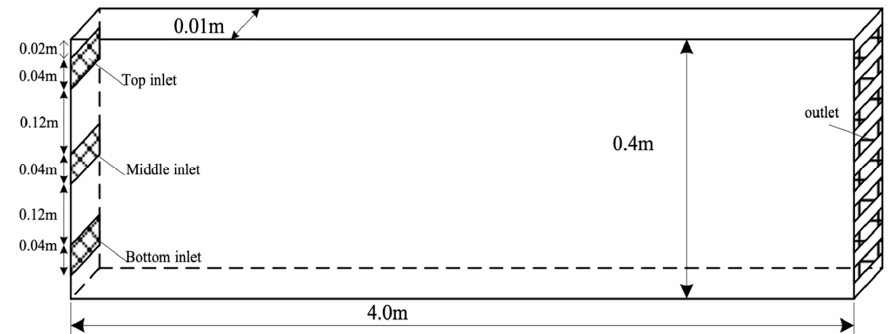
Figure 2. Schematic diagram of slot geometry.